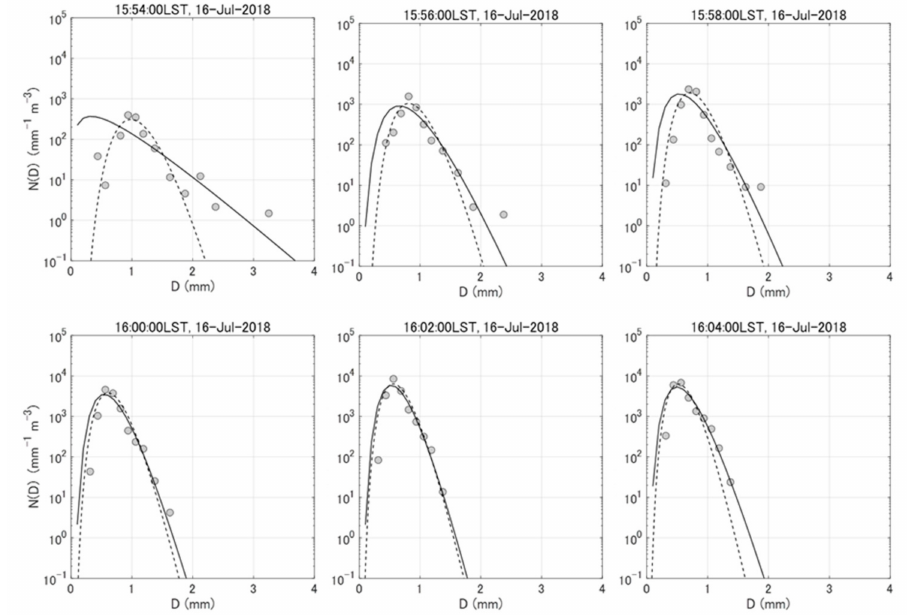
Figure 7. Temporal changes in measured PSD for eruption 6 (16 July 2018). Solid lines and dashed lines are the gamma PDS fitting curves for the measured PSD data by the moment method and non-linear regression analysis, respectively.